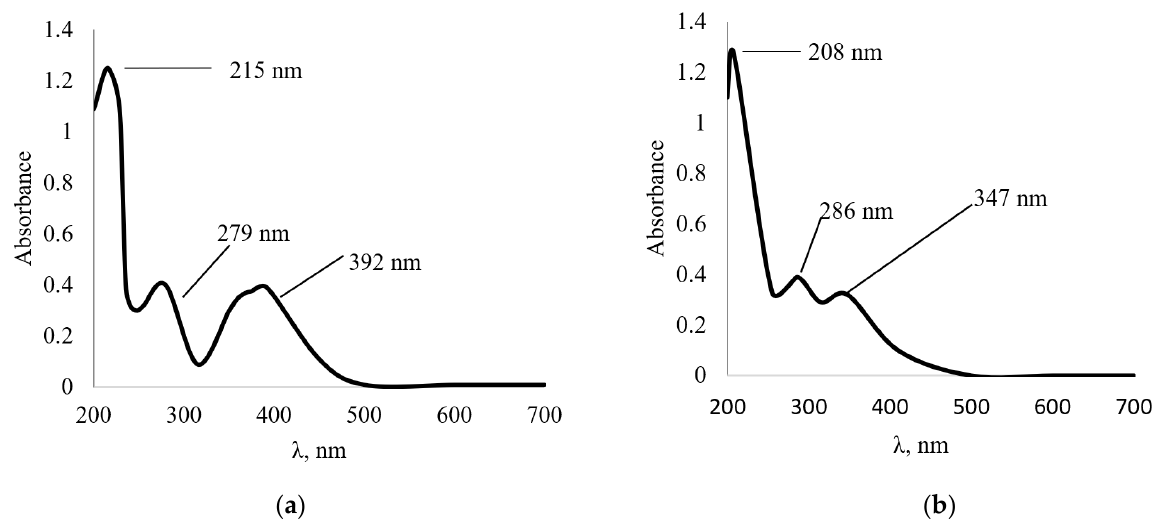
Figure 5. UV spectrum of the synthesized oligomer: ( a ) with instant addition of the condensing agent; ( b ) with smooth introduction of the condensing agent.